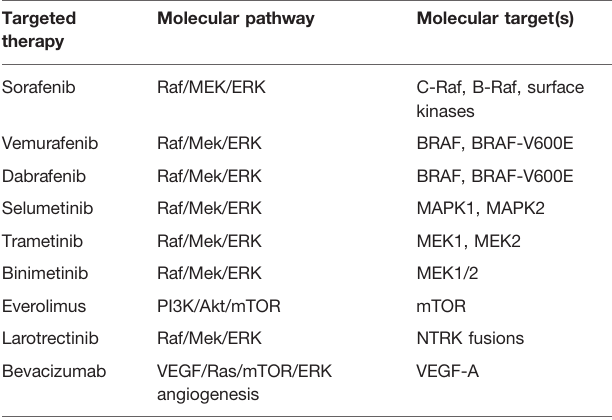
TABLE 2 | Summary of targeted therapies available for OPG treatment. Targeted